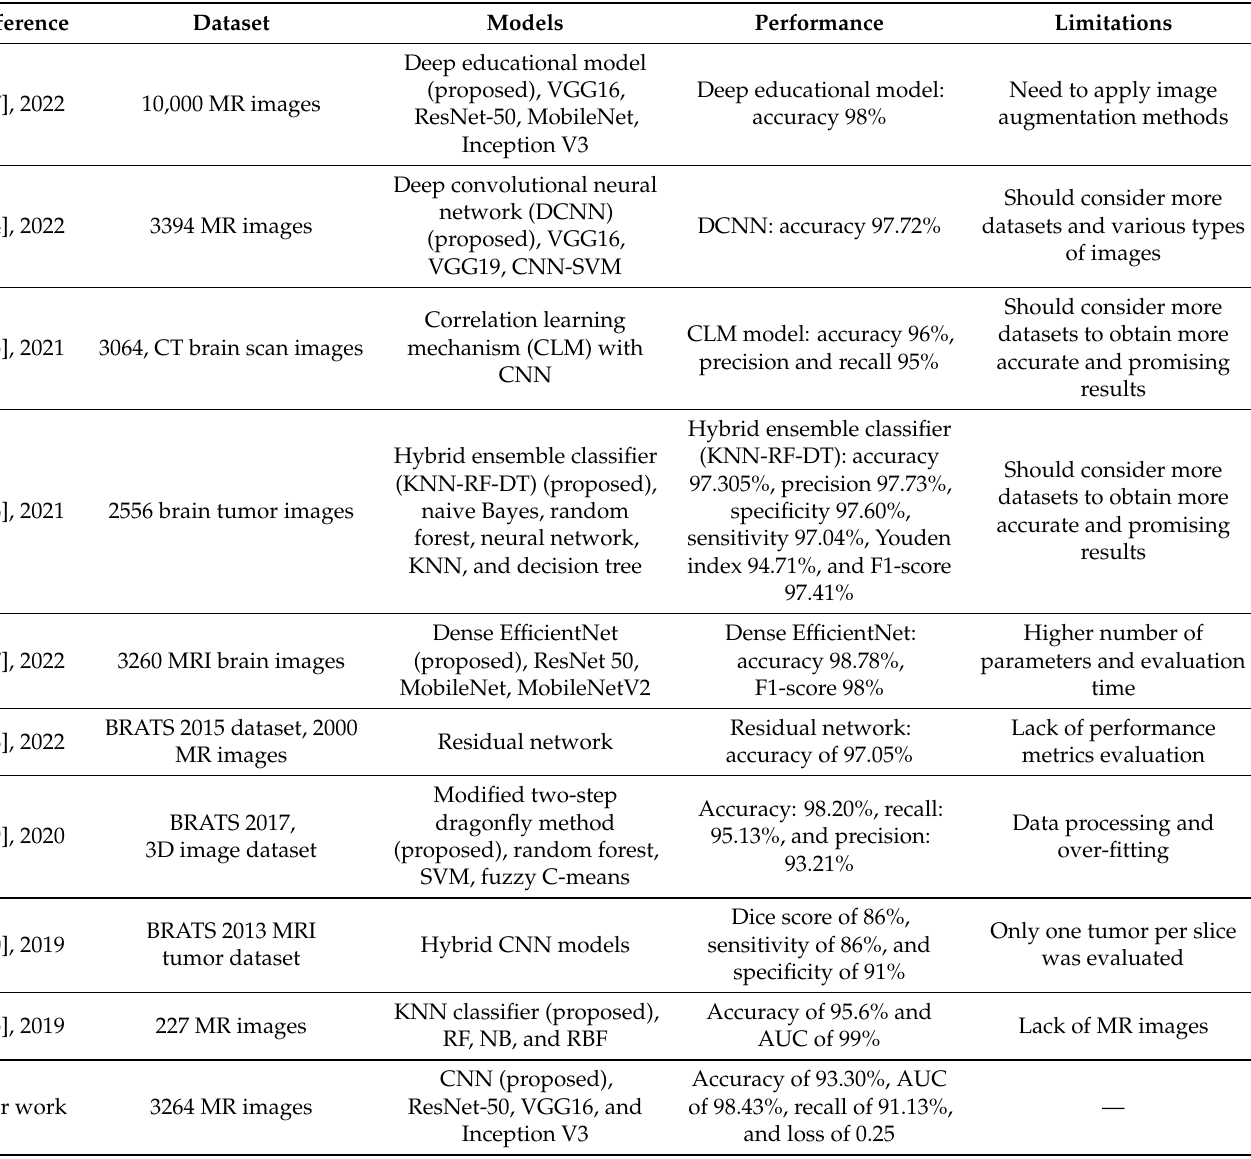
Table 1. Literature